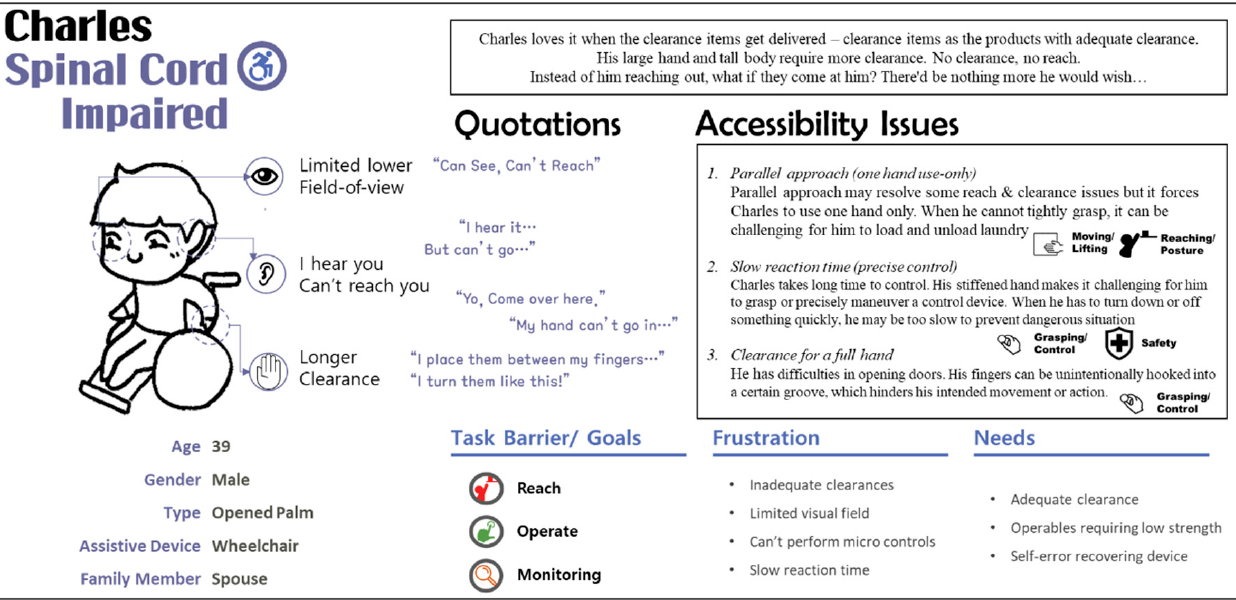
Figure A6. Persona card of Charles, the opened-palm